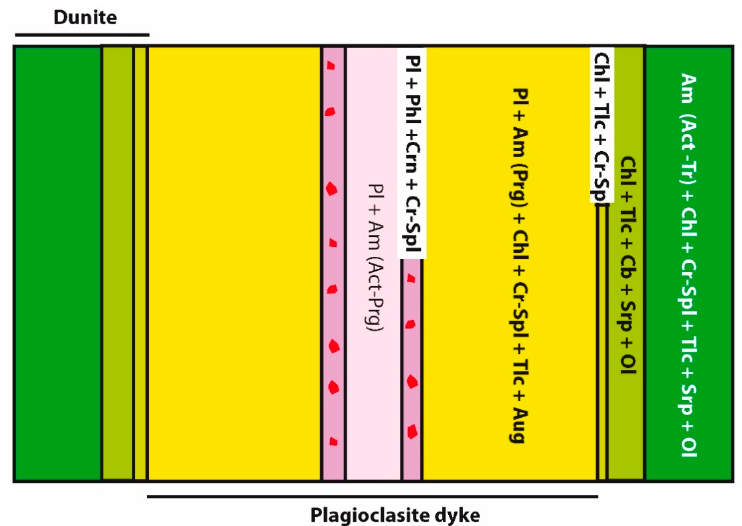
Figure 41. The ruby-bearing plagioclasite dyke in a serpentinized dunite from the Makar Ruz’ deposit in the Ray-Iz ophiolitic belt of Polar Urals, Russia, modified from [99]. The plagioclasite shows a symmetrical metasomatic zoning with sharp contact zones characteristic of metasomatic zoning and percolation of fluids. Ruby (Crn) is hosted in the plagioclase (anorthite)-phlogopite (Phl)-Cr-spinel (Cr-Spl) inner zone of the metasomatic column. Abbreviations: Am = amphibole, Act = actinolite, Tr = tremolite, Prg = pargasite, Tlc = talc, Srp = serpentinite, Ol = olivine, Pl = plagioclase, Chl = chlorite, Aug = augite, and Cb = carbonate.